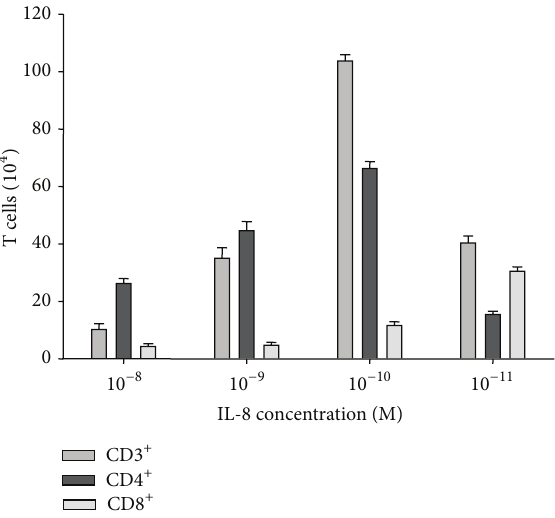
Figure 6: IL-8-induced chemotaxis of T